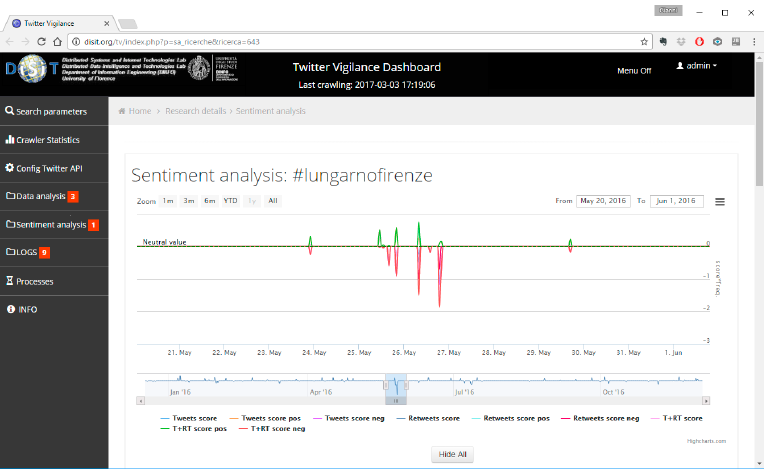
Figure 13. Sentiment analysis on Arno River situation.